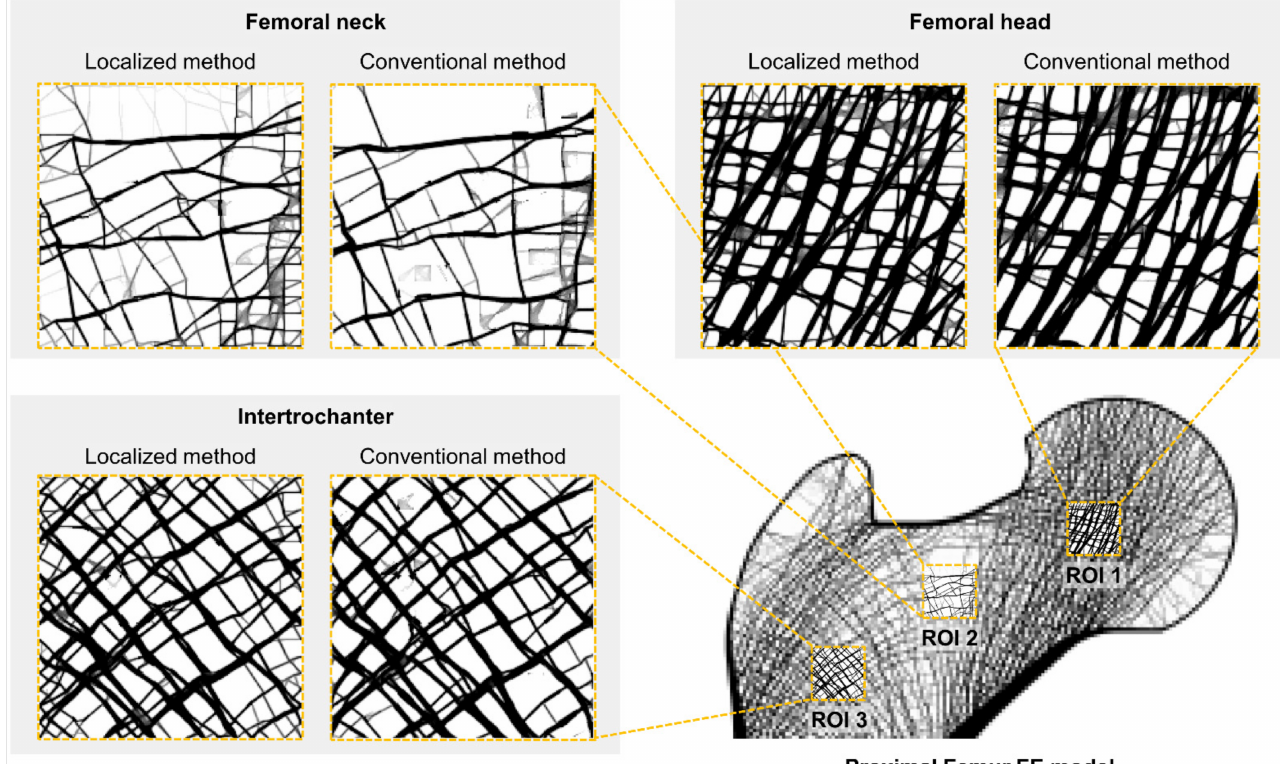
Figure 5. Bone microstructure reconstruction result of 14.4 × 14.4 mm 2 by the conventional and localized method for the proximal